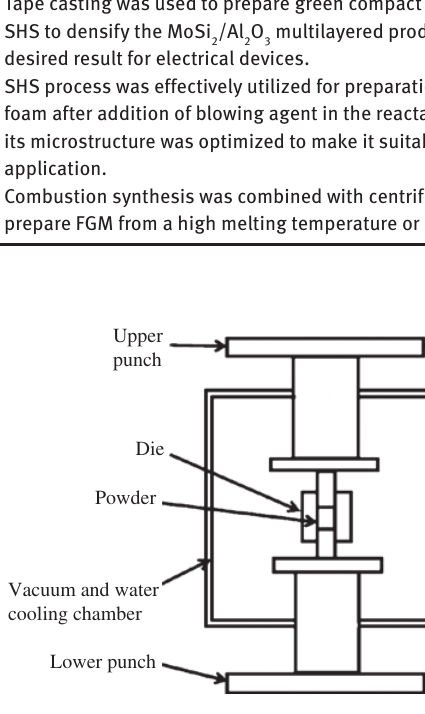
Figure 9: System